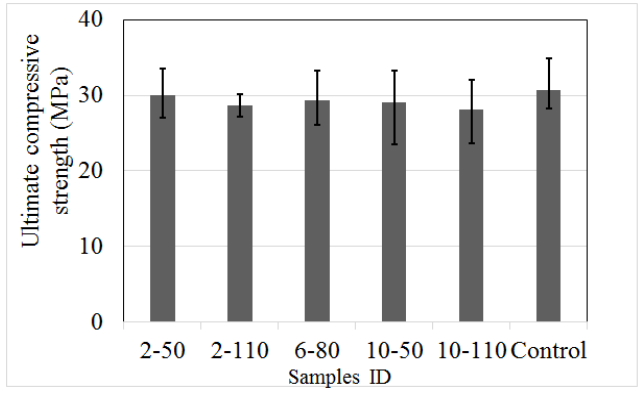
Figure 7. Ultimate compressive strength of control samples and concrete with recycled PET fibres.